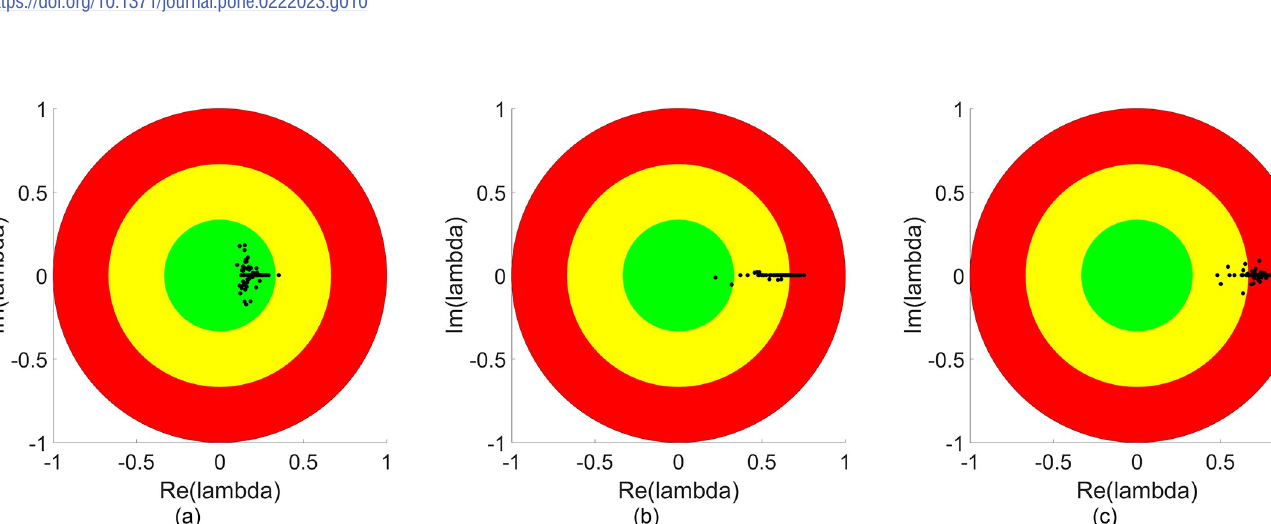
PLOS ONE | https://doi.org/10.1371/journal.pone.0222023 September 11,